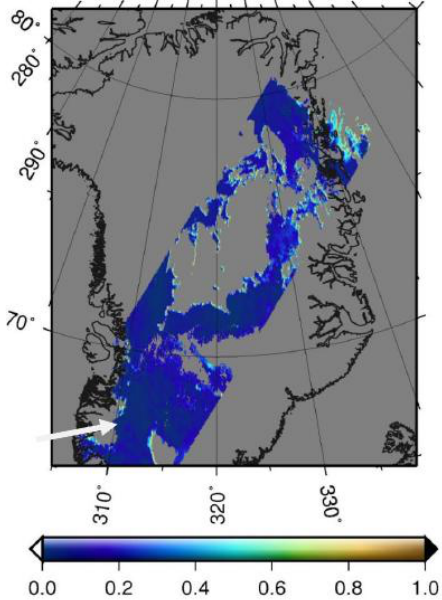
Fig. 16. The map of retrieved AOT over Greenland after the dis- cussed dust event, on 15 July 2008, 14h 32min 18s, orbit number 33330. No evidence of pollution is visible in the Kangerlussuaq area (shown with the